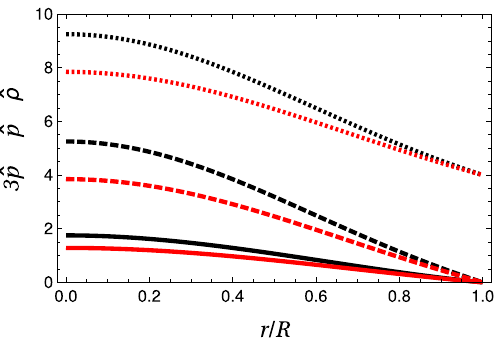
Fig. 2 Same as before, but for normalized energy density, ρ/ B , and normalized pressure, p / B . LEFT: Dimensionless energy density ρ/ B versus normalized radial coordinate r / R for all five scale-dependent interior solution obtained in this work. RIGHT: Dimensionless pressure p / B versus normalized radial coordinate r / R for the five scale-dependent interior solutions